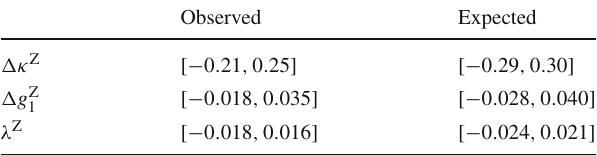
Table 8 One-dimensional limits on the aTGC parameters at a 95% CL for WZ → (cid:5)ν(cid:5) (cid:5) (cid:5) (cid:5) Observed